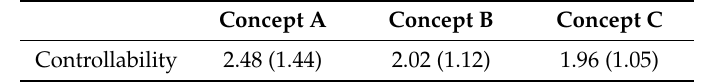
Table 7. Controllability ratings, mean, and (SD) for all six scenarios and concept alternatives.